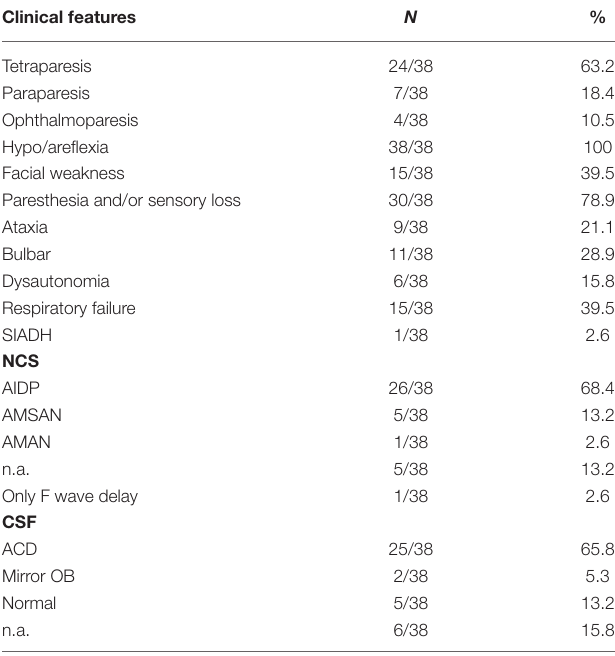
TABLE 3 | Clinical, neurophysiological, and CSF features of Guillain–Barré syndrome/Miller Fisher syndrome cases. Clinical